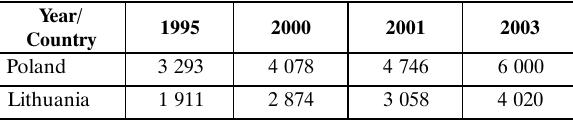
Table 1. Indices of Gross Domestic Product in Poland and